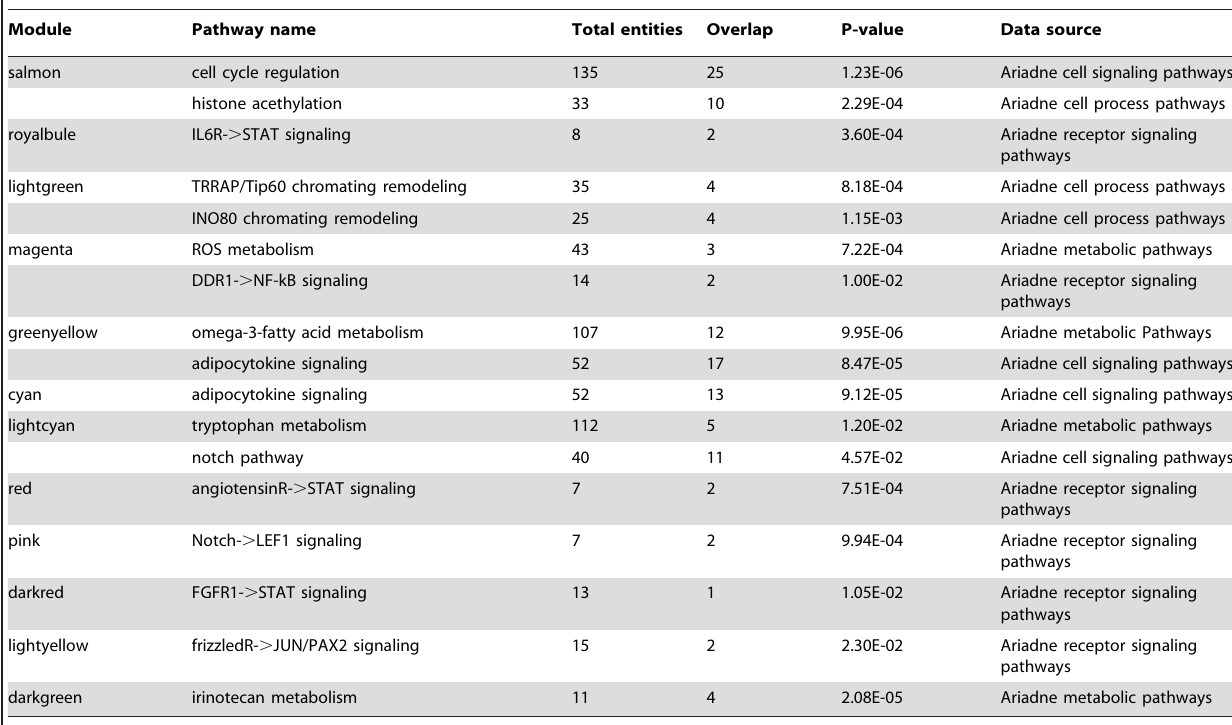
Table 2. Top enriched pathways in LR-related